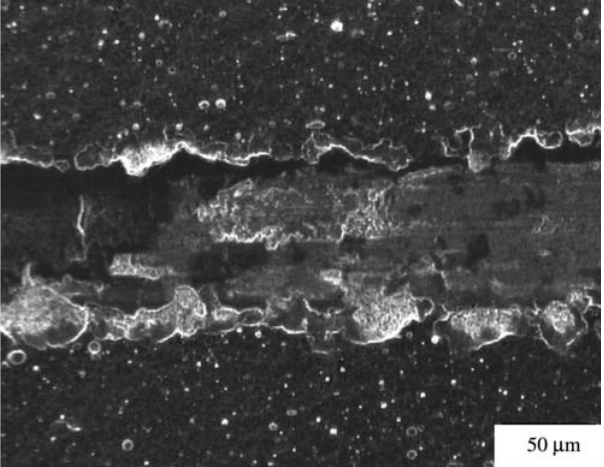
Figure 6. Defects characteristic of the TiN/ (Ti,Al,Si)N/TiN coating surface deposited onto the C1 type cermet.